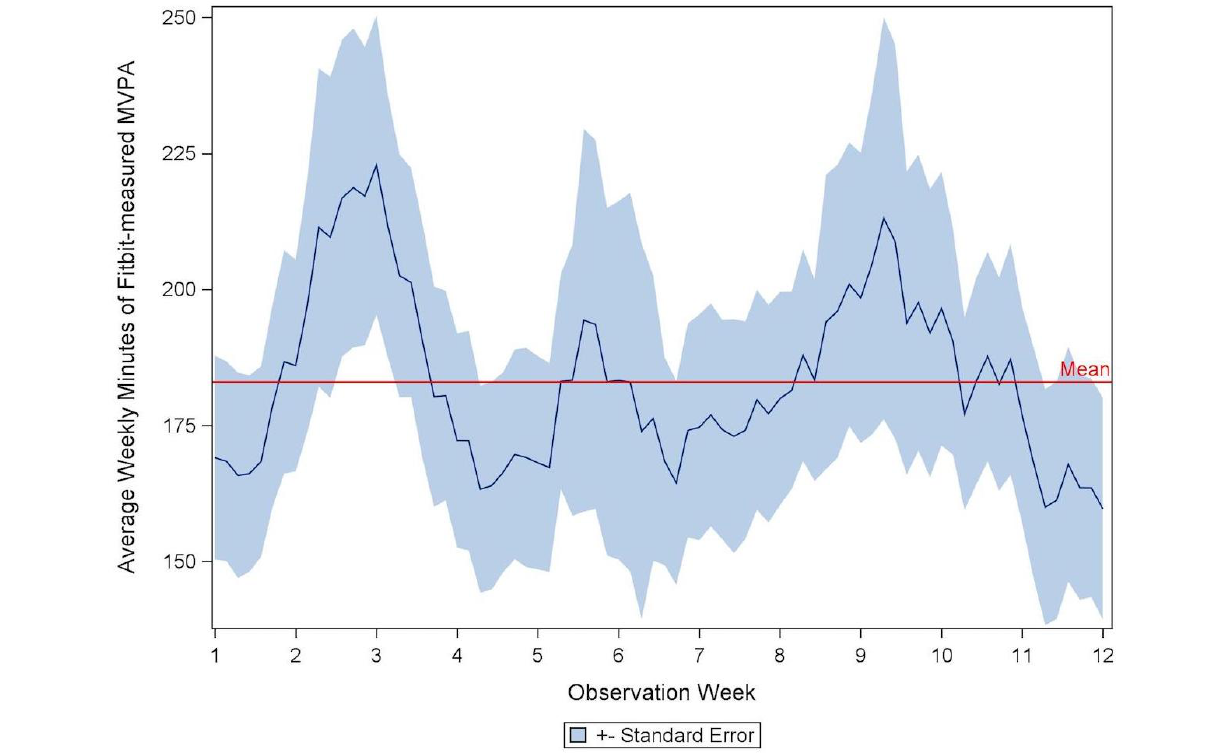
Figure 2. Rolling weekly minutes of Fitbit-measured MVPA, averaged across study participants (standard error), reference line at overall 12 week average,